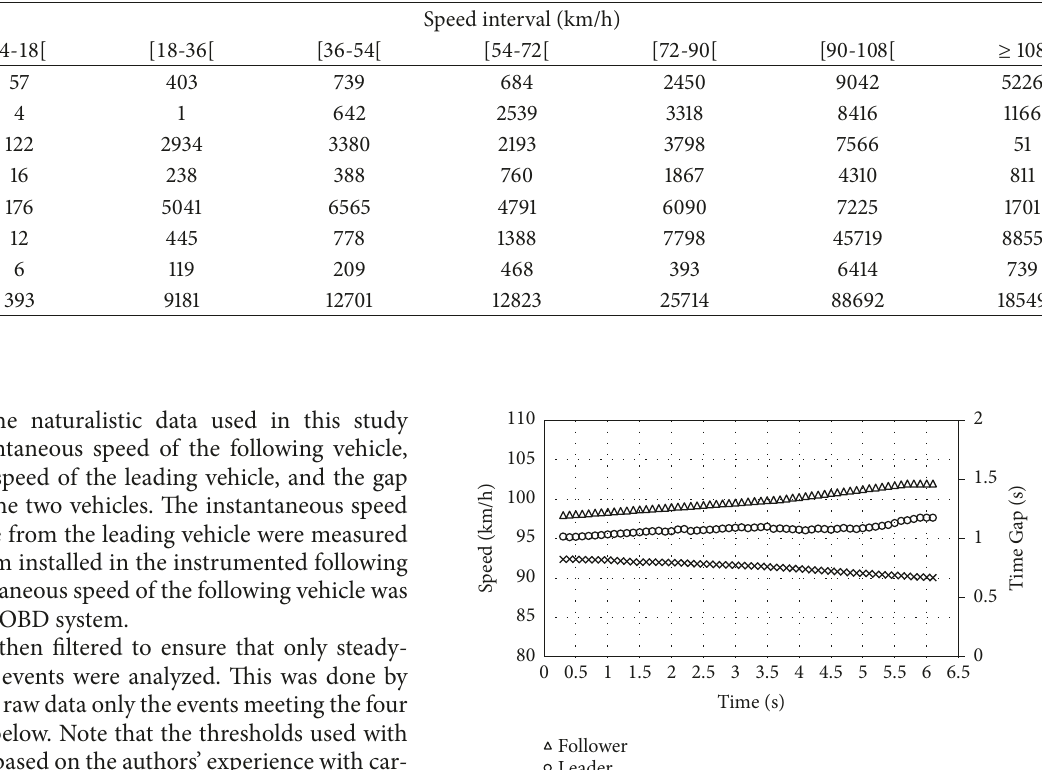
Table 1: Number of time gap samples per driver and per speed interval.